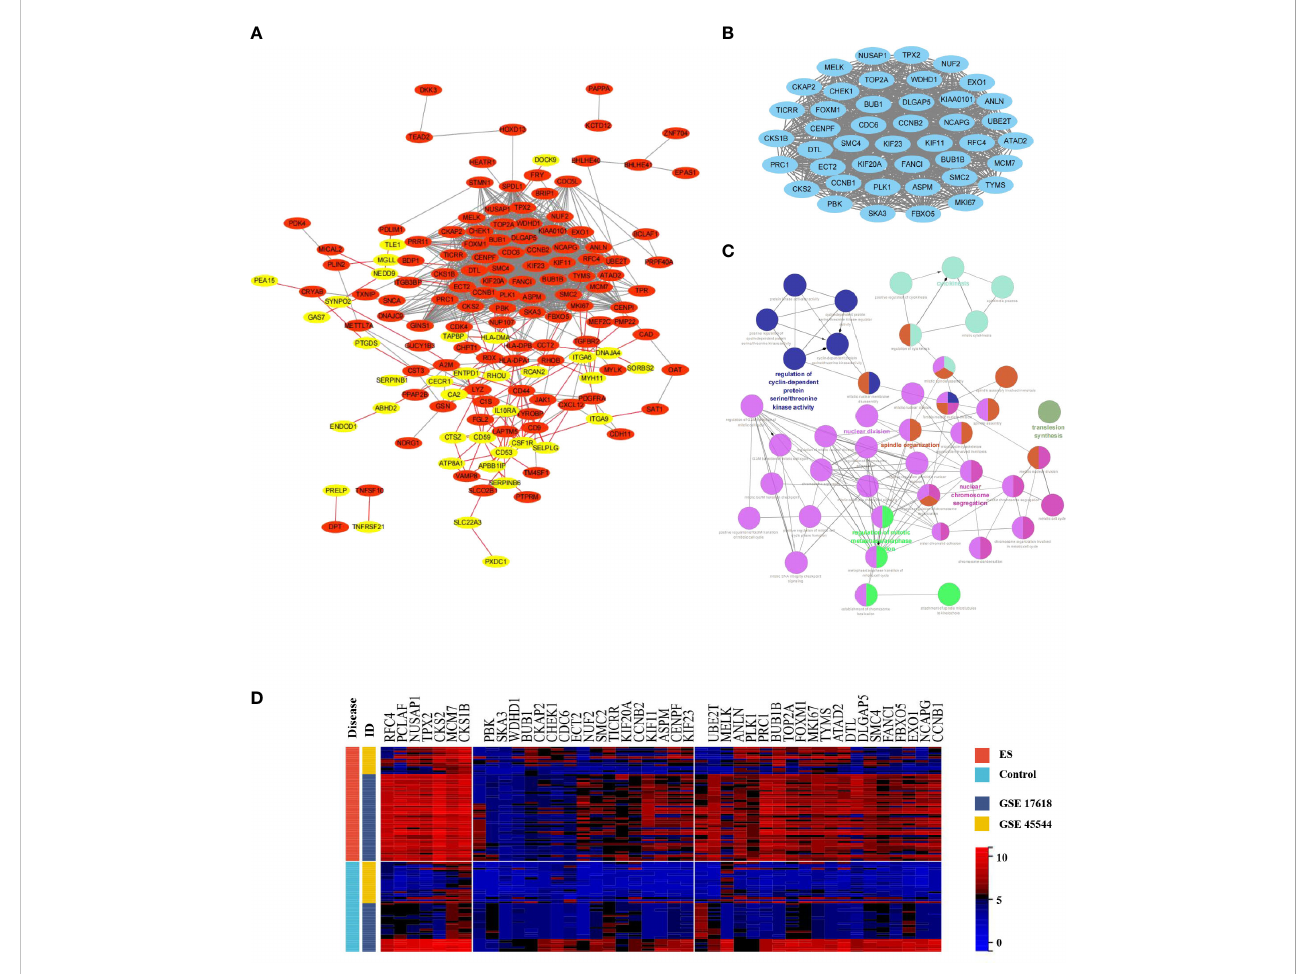
FIGURE 3 Construction of the PPI network, and MCODE module; Biology process analyzation and hierarchical clustering of MCODE-DEGs. (A) The Cytoscape program was built to obtain the DEGs PPI network. Genes upregulated were highlighted in light red, whereas genes downregulated were highlighted in light yellow. (B) The PPI network yielded the most signi fi cant module (MCODE-DEGs), having 43 nodes and 857 edges. (C) ClueGO was employed to evaluate the biological processes of the MCODE-DEGs P < 0.01 was judged statistically meaningful. The node ’ s dark hue represented the recti fi ed P value of ontologies. The quantity of genes participating in ontologies was represented by node ’ s size. (D) The heat map demonstrated signi fi cantly different in expression levels of MCODE-DEGs between the ES and control group. Red represented upregulation of genes; Blue represented